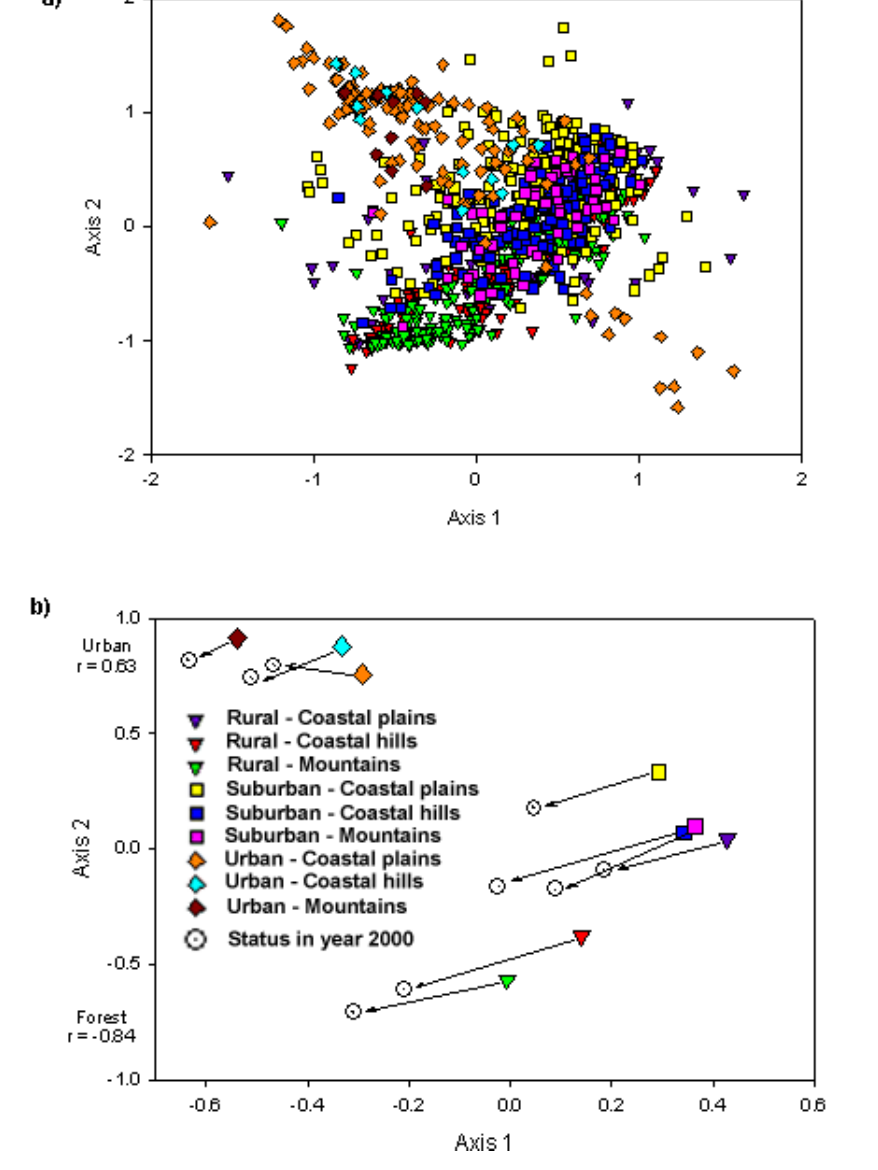
Fig. 5. NMS ordination based on the percentage of land cover for each barrio in 1991 and 2000. a) all barrios from 1991 ( n = 880). The symbol legend is in panel b; b) trends in land-cover change based on the mean of the x and y values of barrios in each population density/location class for 1991 (colored symbols) and 2000 (